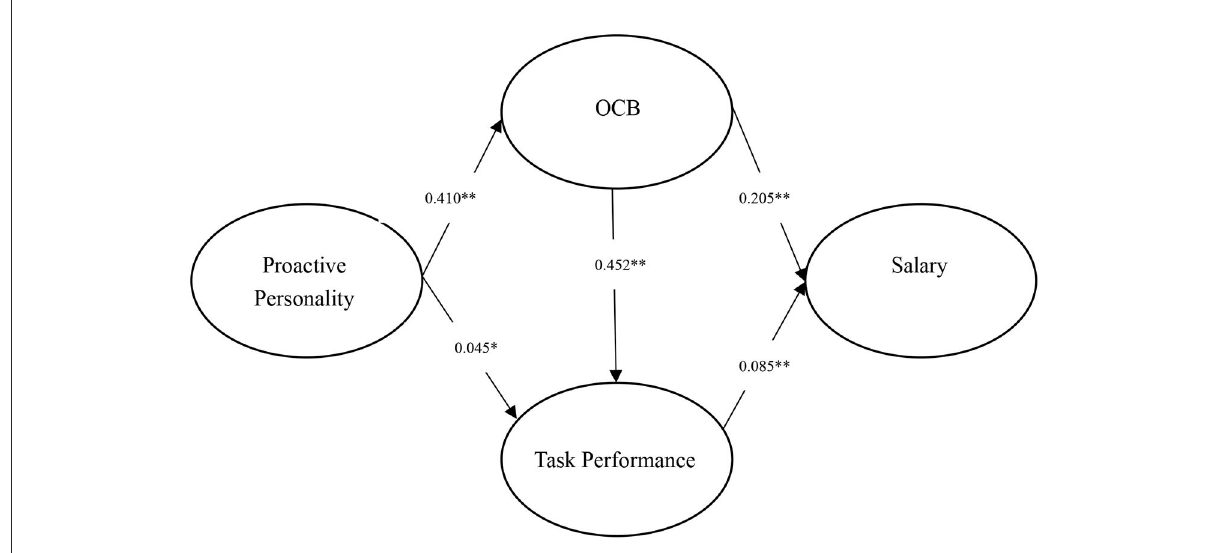
FIGURE5 Results of MASEM for proactive personality and salary. ** p < 0.01; * p <